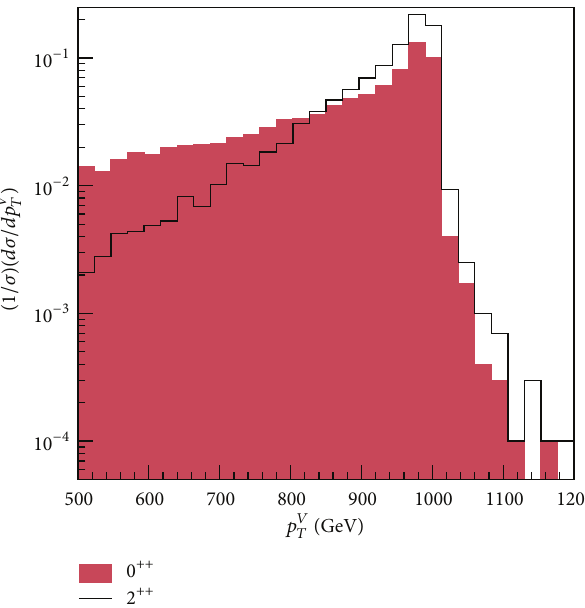
Figure 3: Distribution of the transverse momentum of the leading vector boson in the decay of 0 ++ and 2 ++ resonances at 8 TeV